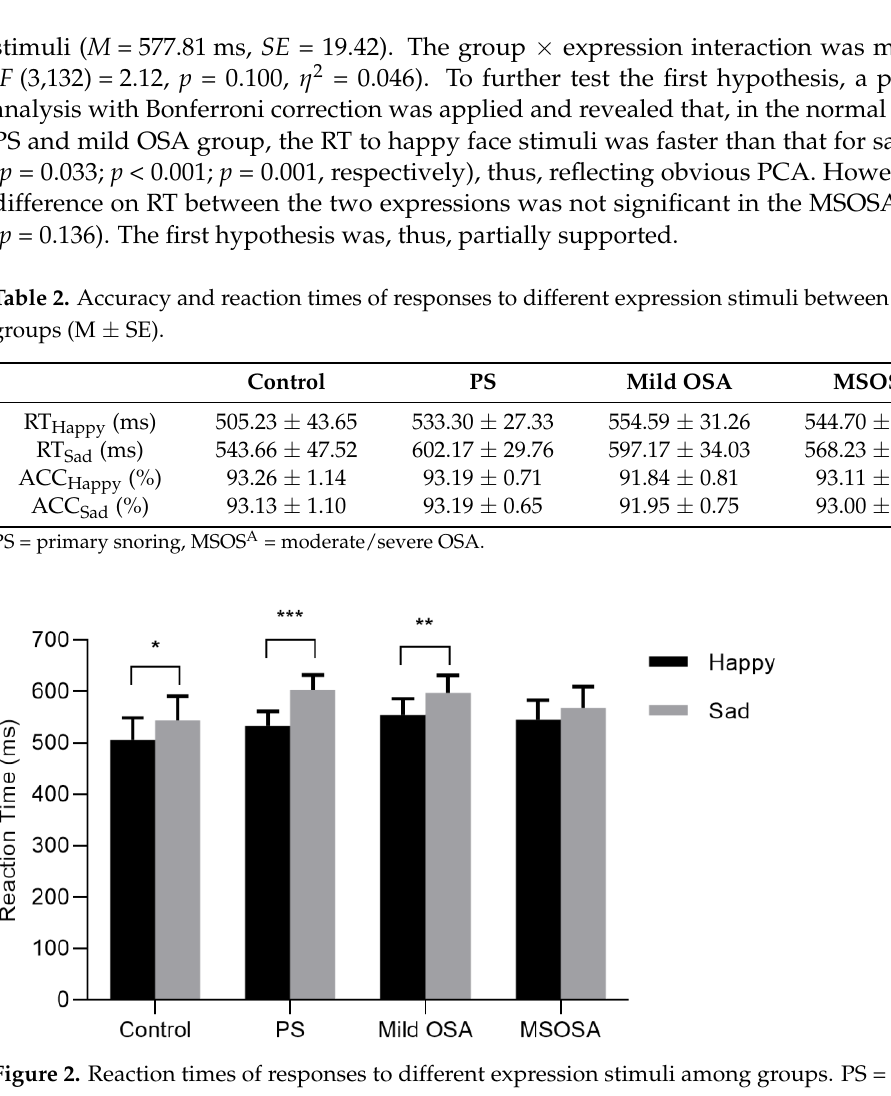
Figure 2. Reaction times of responses to different expression stimuli among groups. PS =